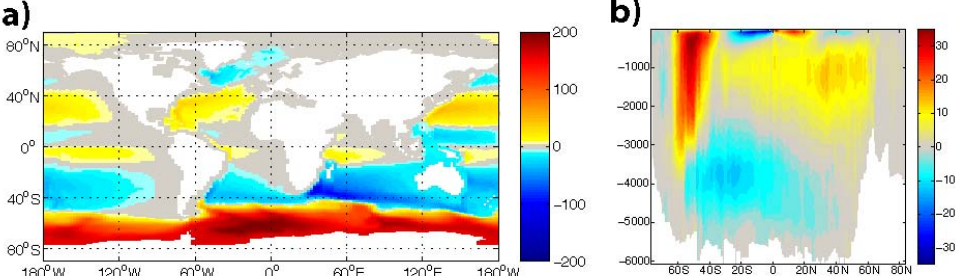
Fig. 6. Simulated mean (1978–2007) global circulation pattern. (a) Barotropic stream function in Sv (10 6 m 3 s − 1 ). (b) Global meridional overturning circulation in Sv.